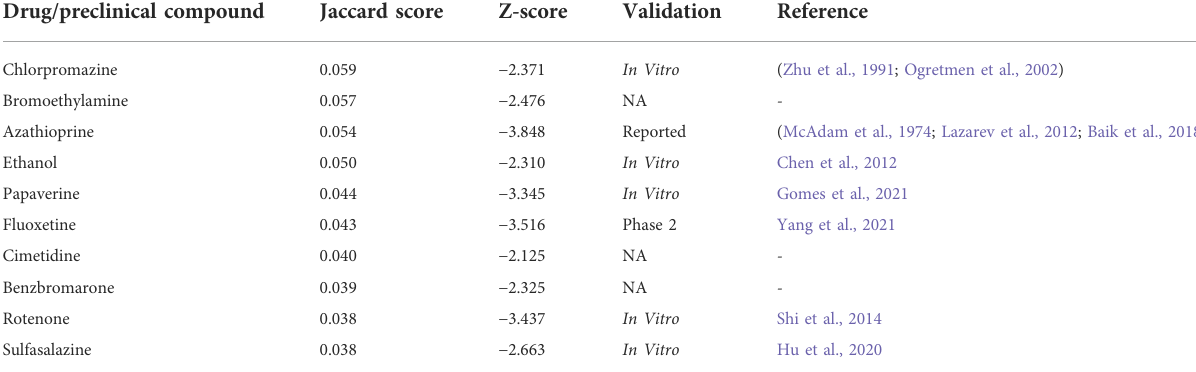
TABLE 2 Potential drugs or preclinical compounds for lung